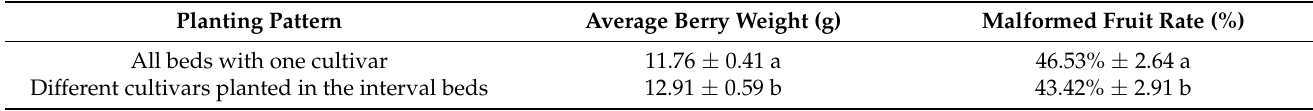
Table 9. Interplanting impacts on the pollination efficiencies (bee number is 4000). Planting